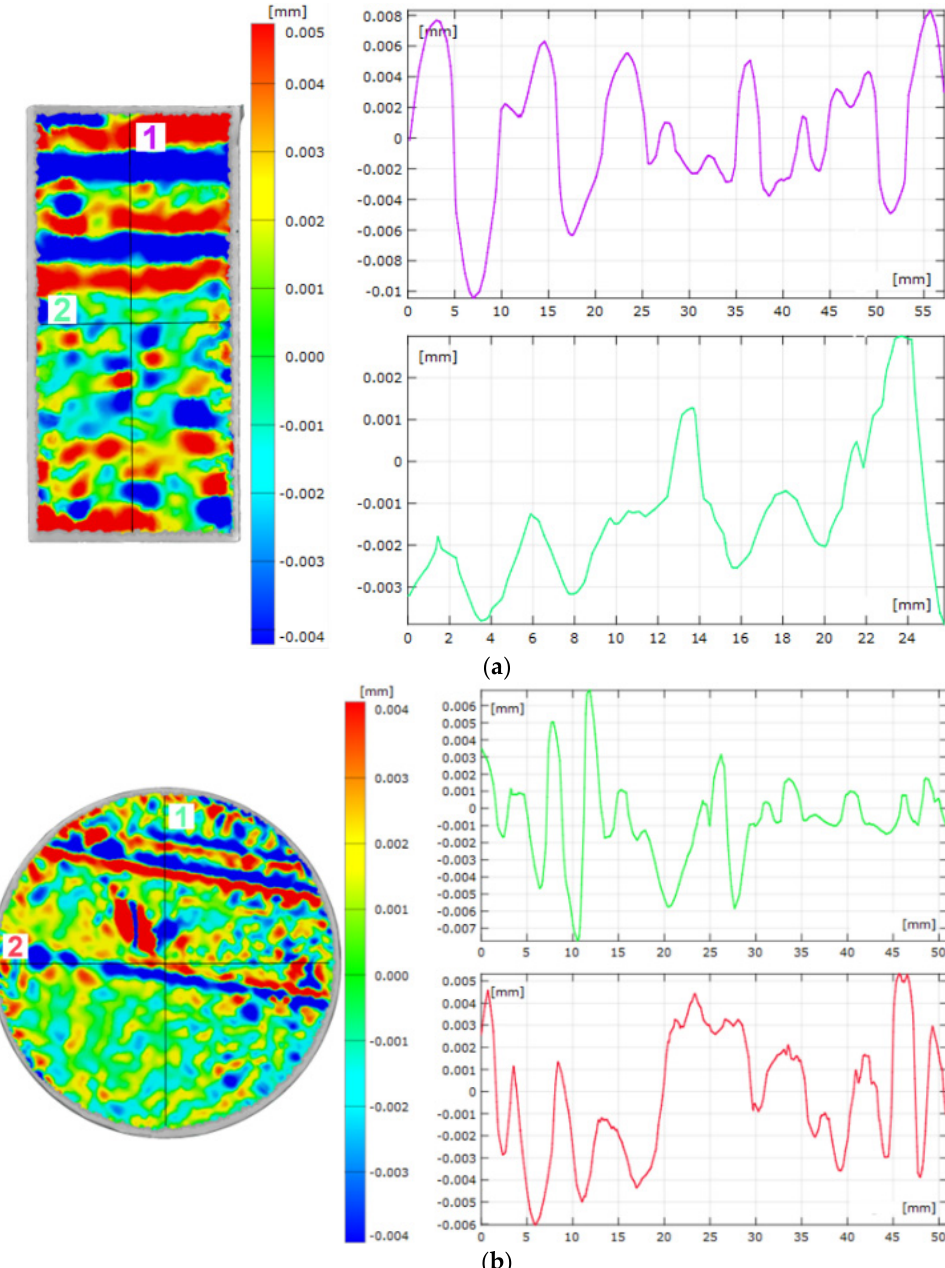
Figure 5. Surface topography: ( a ) DMLS sample; ( b ) as-cast sample. Number 1 is the measurement perpendicular to the sample building direction, while number 2 is the measurement taken parallel. The same measurement methodology was used for the cast sample.